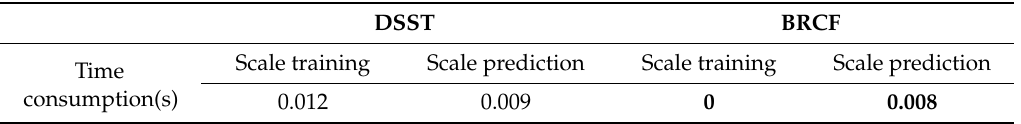
Table 3. Comparison of time consumption on scale